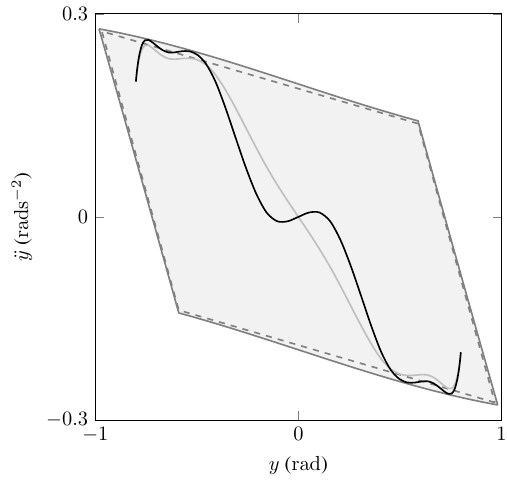
Figure 3. Solutions for the flexible manipulator problem with a polytopic approximation (gray) and semi-algebraic approximation (black).